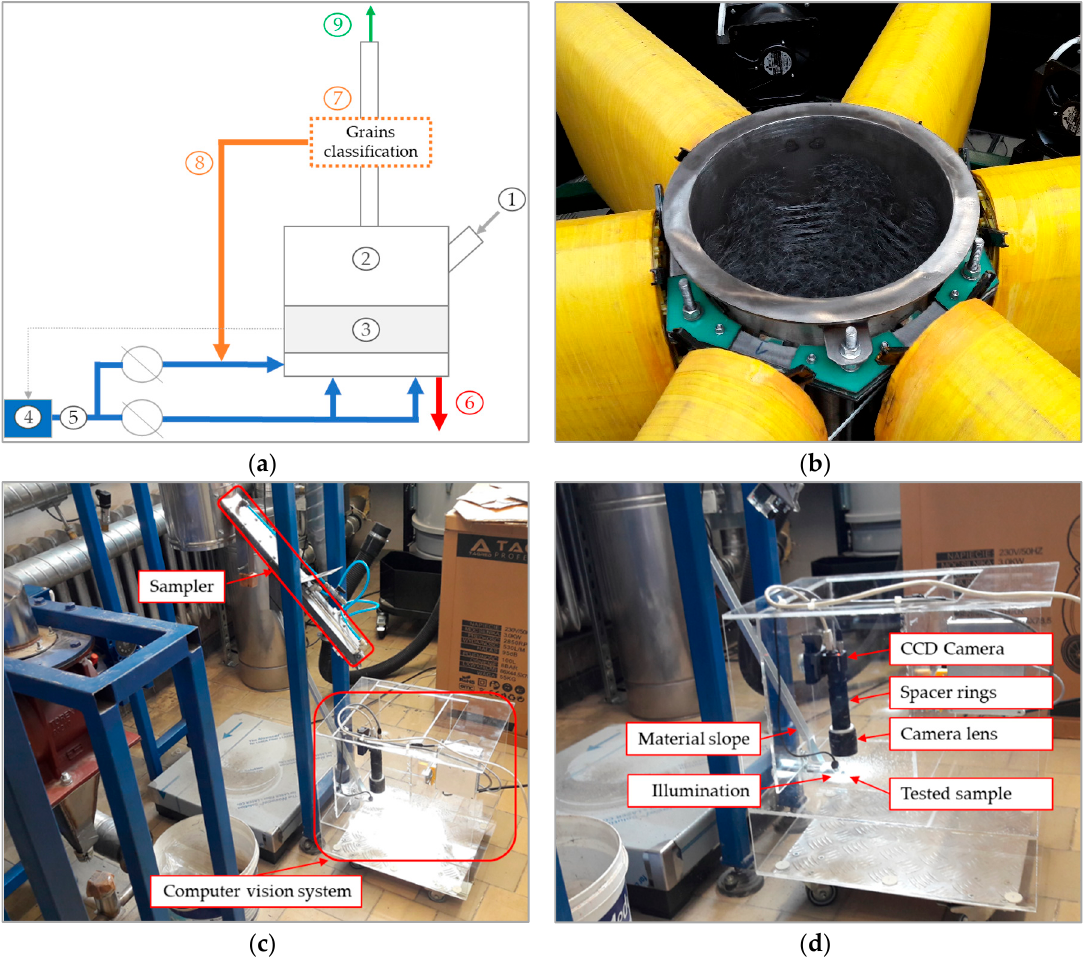
Figure 2. Schematic representation of the electromagnetic mill ( a ), working chamber with visible grinding media ( b ), a part of electromagnetic mill with sampler and computer vision system ( c ), the laboratory stand with computer vision system ( d ).